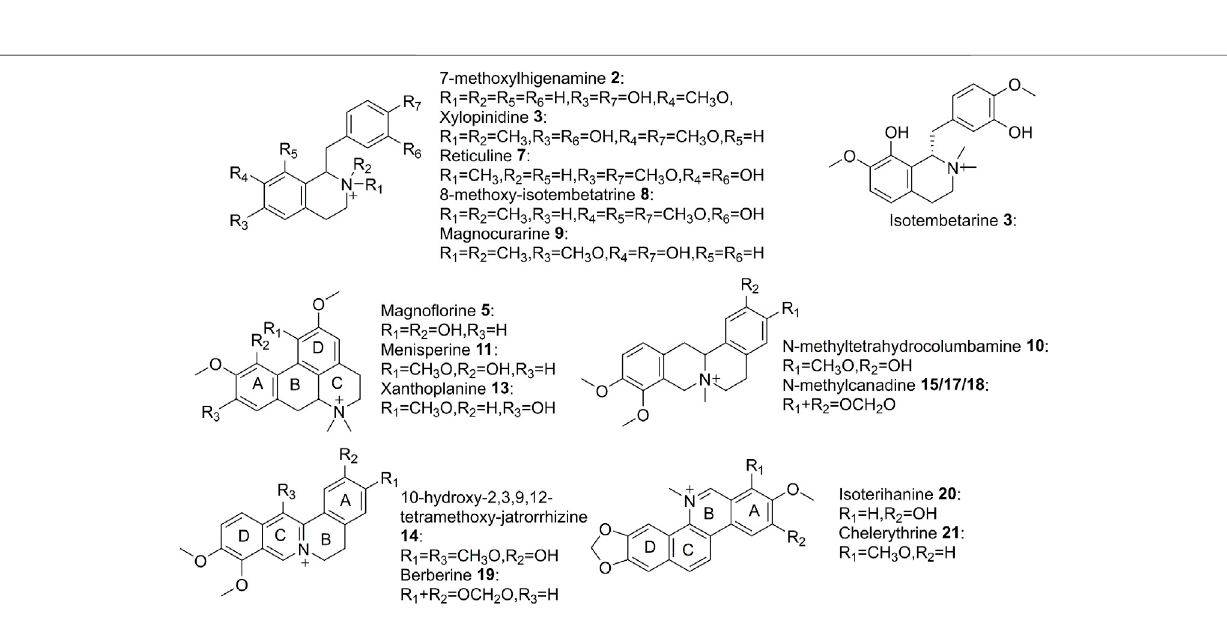
FIGURE 3 | Structures of alkaloids detected in